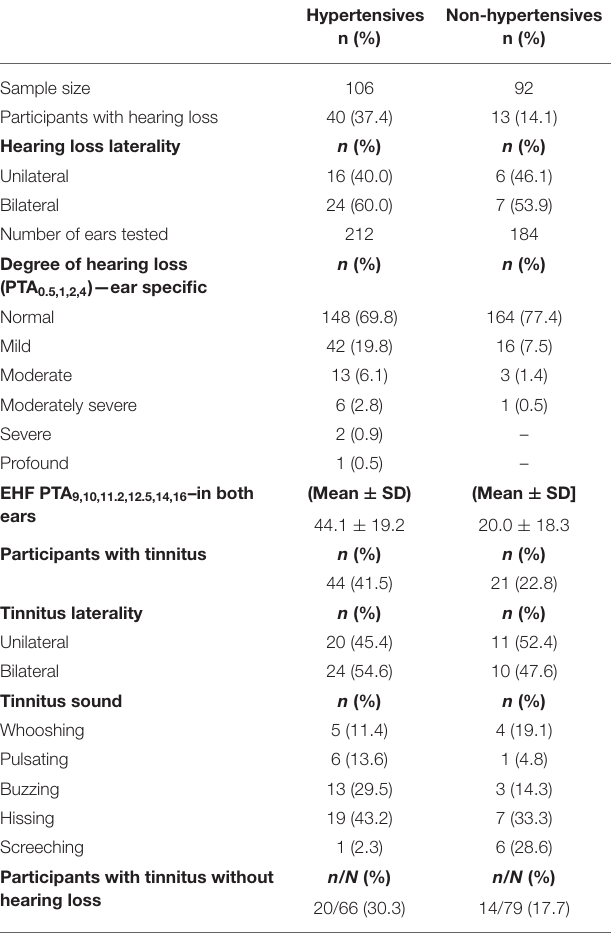
TABLE 3 | Prevalence and characteristics of auditory deficits among hypertensive and non-hypertensive adults.